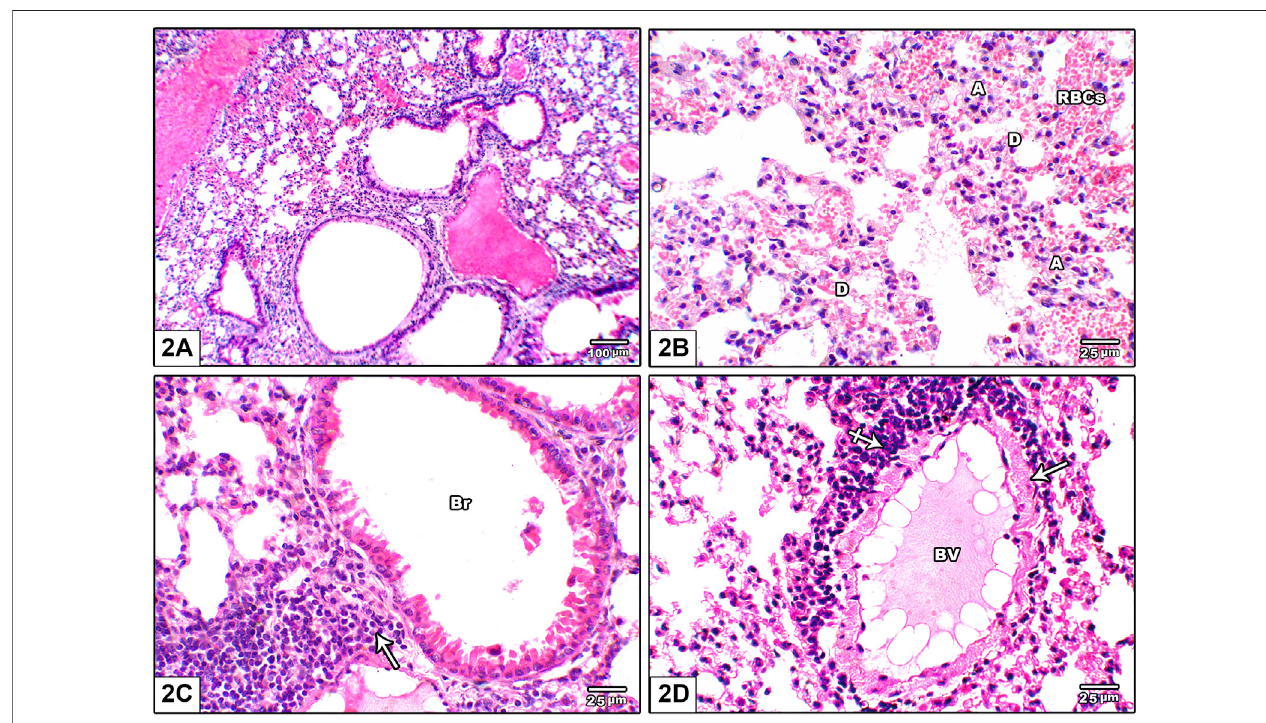
FIGURE 2 | Photomicrograph of H&E stained lung from le fl unomide 2.5 mg/kg group (A) Altered lung architecture with mild in fi ltration by mononuclear in fl ammatory cells, zones of non-regular air spaces with damaged inter-alveolar septa and narrowing alveoli (B) An image shows presence of collapsed alveoli (A) and some dilated ones (D) with thickened interalveolar septa and mononuclear in fl ammatory cell in fi ltrate in pulmonary interstitium with mild interstitial and alveolar hemorrhage (RBCs) (C) An image shows widening ofthe interstitium by mononuclear in fl ammatory cell in fi ltrate (arrow) (D) An image shows congested pulmonary blood vessels (BV) with minor perivascular cuf fi ng by in fl ammatory in fi ltrate (crossed arrow) and increased wall thickness